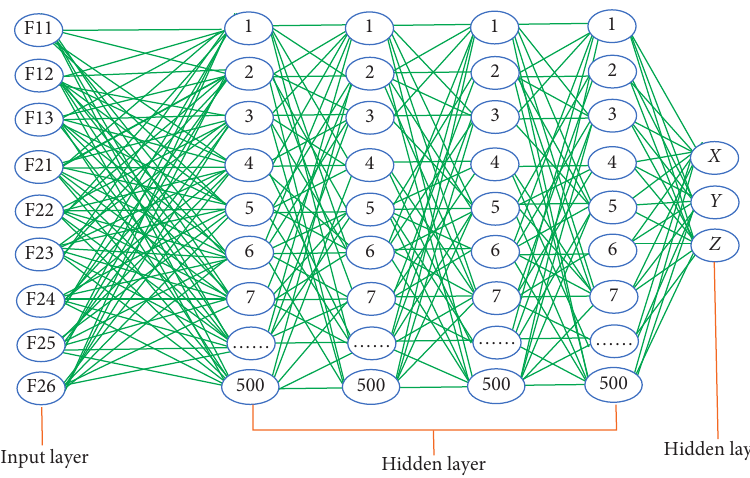
Figure 10: The architecture of network with hidden